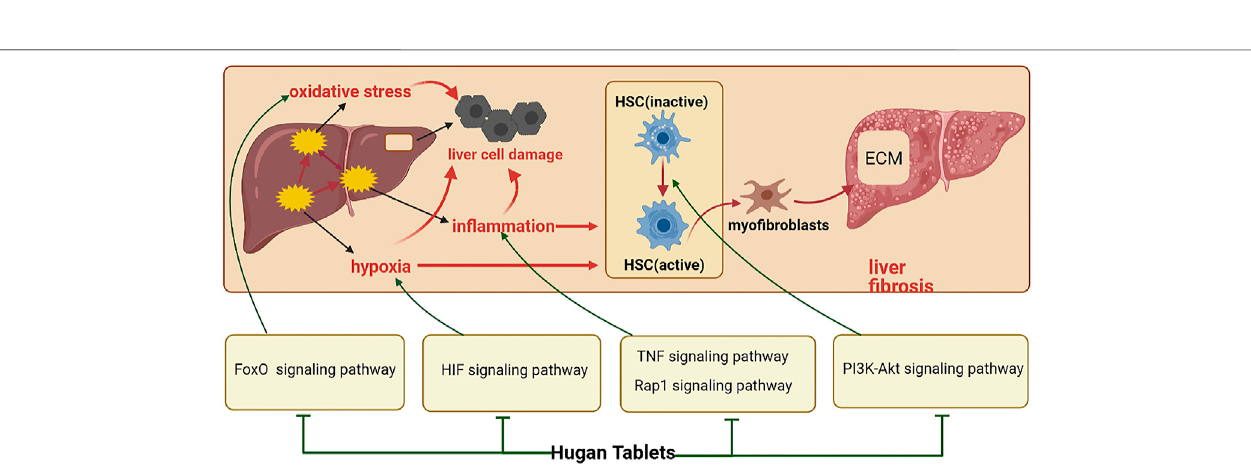
FIGURE 7 | Potential mechanism of Hugan tablets in treating